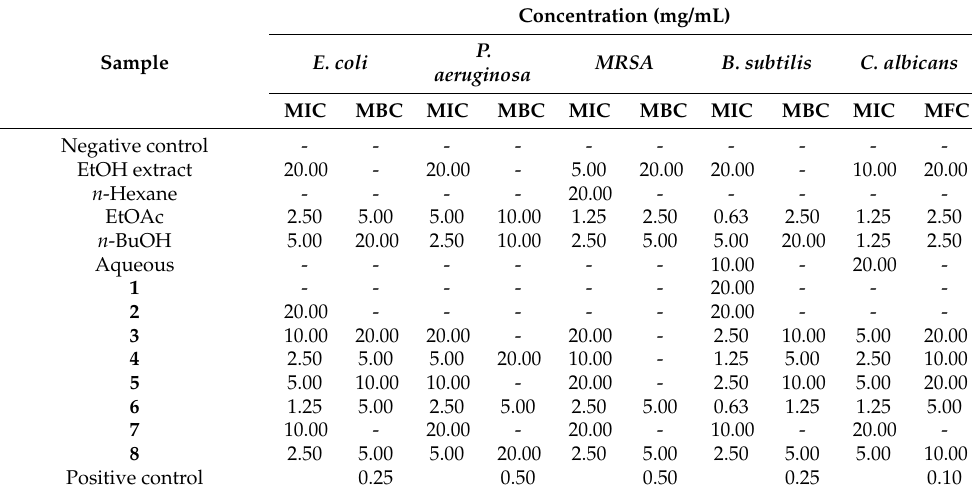
Table 2. Antimicrobial activities of G. braunii